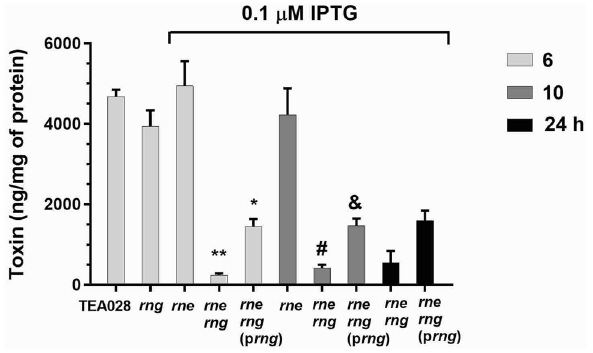
Figure 3. Toxin (Stx2a subtype) production by EHEC containing normal levels of RNases E and G versus derivative strains deficient in either or both enzymes. Cultures of TEA028 (parental strain) and its RNase E/G derivatives were grown in LB medium to an optical density at 600 nm of 0.30–0.35 at which point the cultures were treated with MMC (1 µg/mL) to induce the phage lytic cycle and toxin production. Thereafter, samples were collected at the indicated time intervals, and toxin concentrations were determined in whole cell lysates. The strains TEA028- rne , TEA028- rne -Δ rng , and TEA028- rne -Δ rng (p rng ) underproduce RNase E when the medium is supplemented with 0.1 µM IPTG. Means and standard errors of at least 4 biological replicates are graphed. Abbreviations: rng : TEA028-Δ rng ; rne : TEA028- rne ; rne rng : TEA028- rne -Δ rng ; rne rng (p rng ): TEA028- rne -Δ rng (p rng ). * Adjusted P value versus TEA028 = 0.0001; ** adjusted P value versus TEA028 < 0.0001; # adjusted P value versus TEA028- rne at 10 h = 0.0001; & adjusted P value versus TEA028- rne at 10 h =